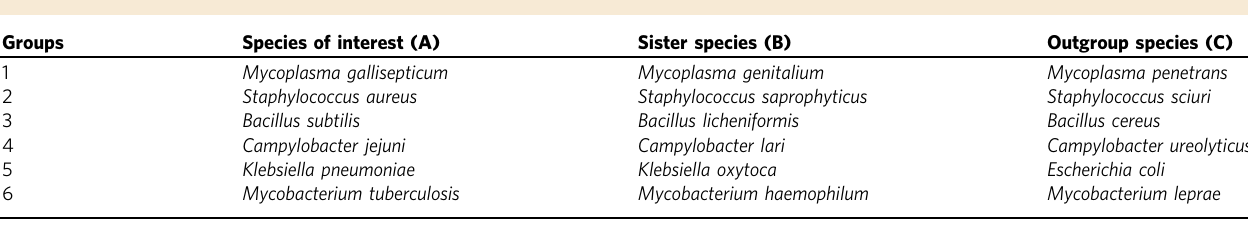
Phylogenetic relationships in each group are based on published phylogenies.